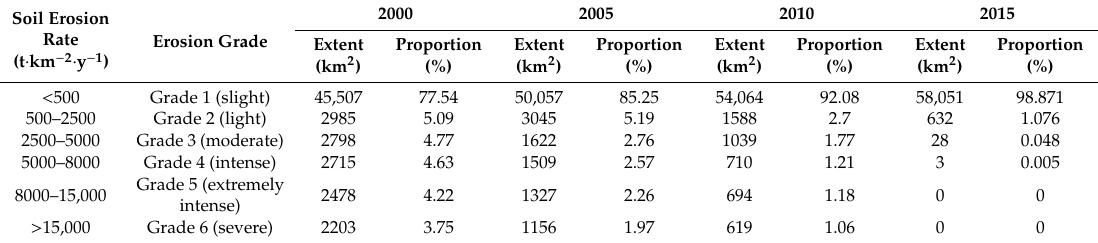
Table 4. Importance of changes in land cover types on soil erosion.